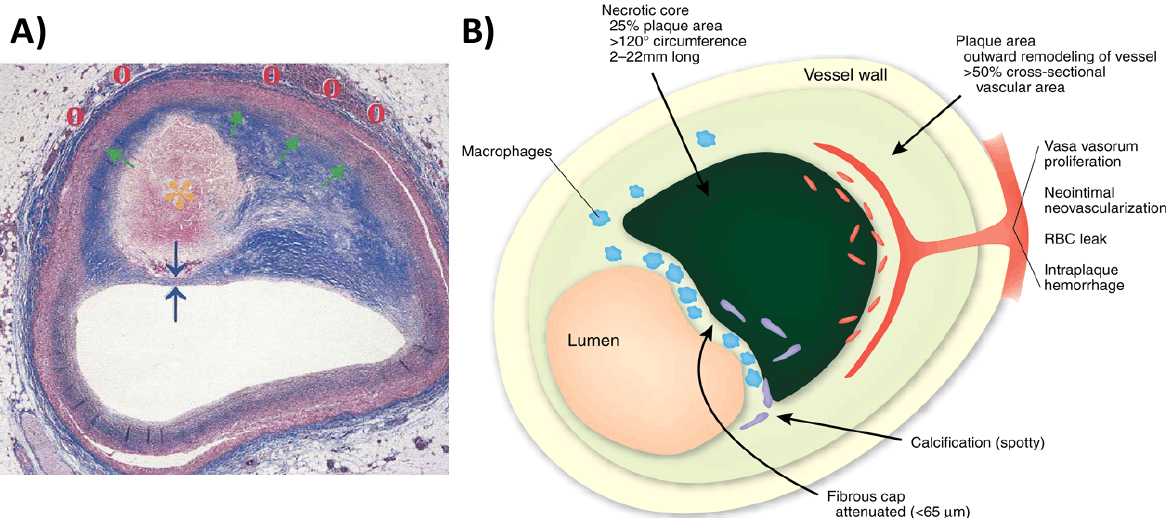
Figure 1. ( A ) Cross section of a rupture-prone coronary artery plaque with a (1) large lipid-rich necrotic core (orange asterisk), (2) thin fibrous cap (blue arrows), (3) expansive remodeling (green arrow), and (4) vasa vasorum and neovascularization (red circles) (adapted from Falk) [4]. ( B ) Schematic of a vulnerable plaque highlighting the features associated with plaque instability (adapted from Narula)